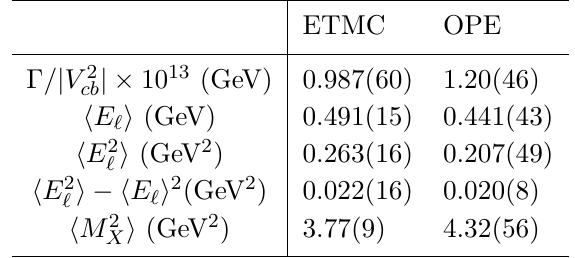
Table 3 . Total width and moments in the ETMC